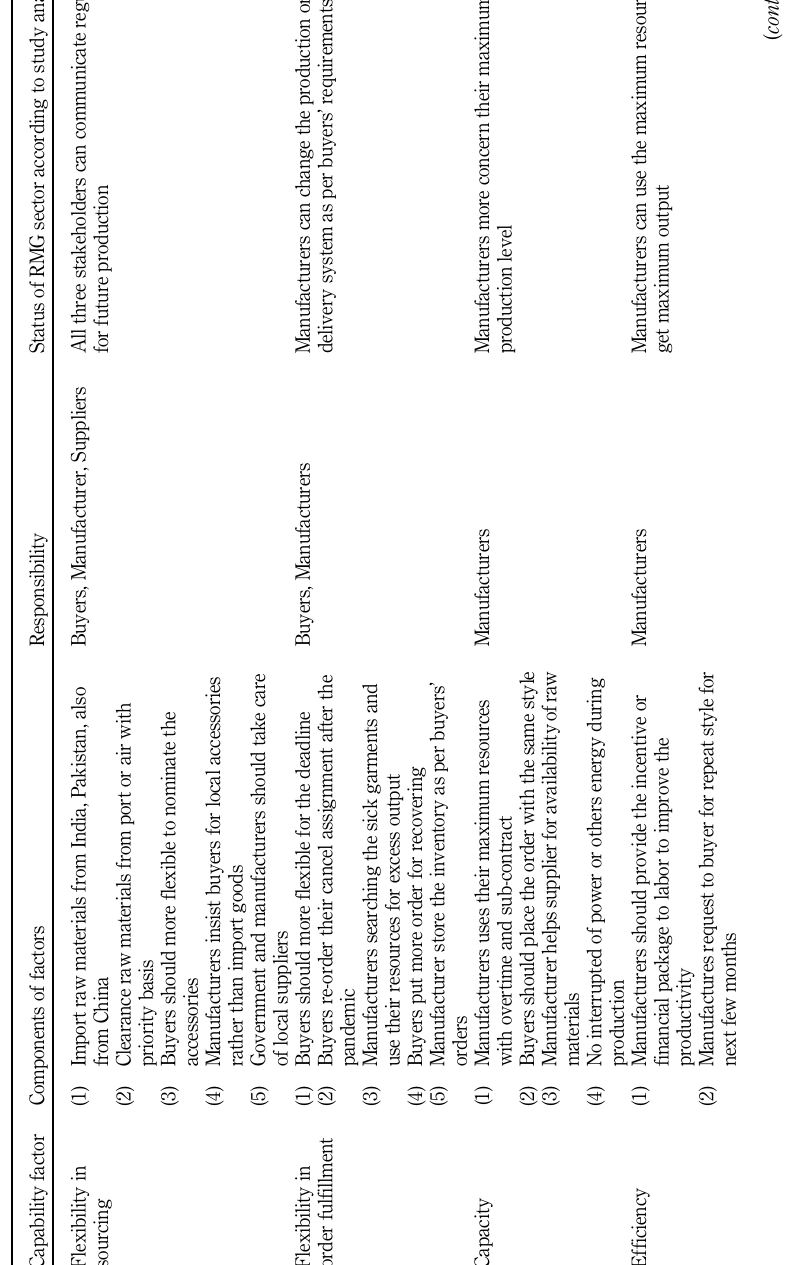
Table 2. Supply chain resilience capacity of RMG in